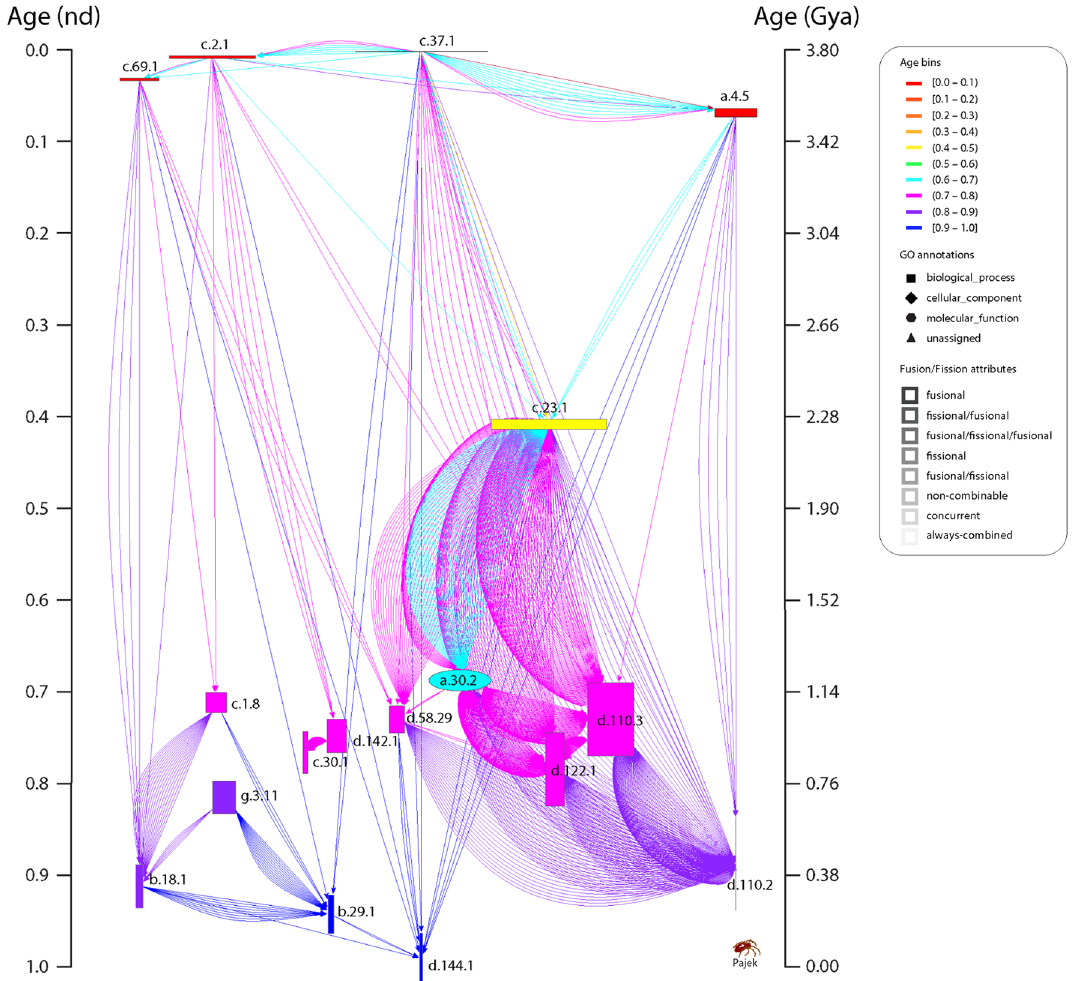
Figure 3. An extant SPX network in waterfall layout describing the evolution of spliced domains with the largest (100th percentile) network connectivity. The SPX network of 1,643 spliced domains was reduced with the restrictive criterion of excluding nodes with combined outdegrees and indegrees ≥ 99% of those of the rest of the nodes. The set of arcs (arched arrows symbolizing flow of time) was also reduced to pairing events between domains in the 100th percentile connectivity and excluded those between contemporary nodes. Nodes are arranged top-down and colored according to age ( nd ) on a relative 0-to-1 scale that describes evolutionary time events. Ages are also time-calibrated with a molecular clock of FSF domains, which uses fossils and microfossils, geochemical, biochemical, and biomarker data 47 . FSF origin is given in billion years ago (Gya). Nodes were labeled with SCOP ccs domain descriptors. To showcase source-and-sink relationships, node symbol sizes were scaled proportional to the weighted outdegree and indegree along the horizontal and vertical axes, respectively. Weighted degrees were scaled as × 2 + 2 to include 0-degree nodes for better visualization. The modular spread of nodes was based on VOS clustering (see methods). Arcs are color-coded according to the age of the more recent of the component nodes involved; no arcs were present in the ancient-most age bin (red) of the timeline. Angles of multiple arcs emerging from nodes are incremented by 2 to avoid both the networks. As expected, the average γ based on less representative outdegree of each of the five networks remained low (1 ± 0.05). We noticed biphasic patterns when -γ was plotted over network connectivity, with two minima at nd ~ 0.37 and ~ 0.67. Moreover, the scale-free tendency of adjacency networks seemed comparatively higher than that of networks lacking the adjacency restriction. For instance, the average values of γ for the PAX and SPAX networks (1.87 ± 0.06 and 2.13 ± 0.07, respectively) were relatively higher than those for the corresponding parent PX and SPX networks (1.61 ± 0.05 and 1.89 ± 0.06, respectively). This suggests that proximity in amino acid sequence plays a major role in rendering the power-law behavior of evolving networks of domain organization. Overall, the average γ of CX (2.56 ± 0.06) remained the highest along the evolutionary timeline, indicating that composition strongly elicits the preferential attachment property. A complementary transition from random to non-random behavior (RVN p value: 1 → 0) in ancient networks ( nd ~ 0.3) implies deviation from randomness as biological networks evolve. Remarkably, this transition event coincides with the origin of a processive ribosome. Such